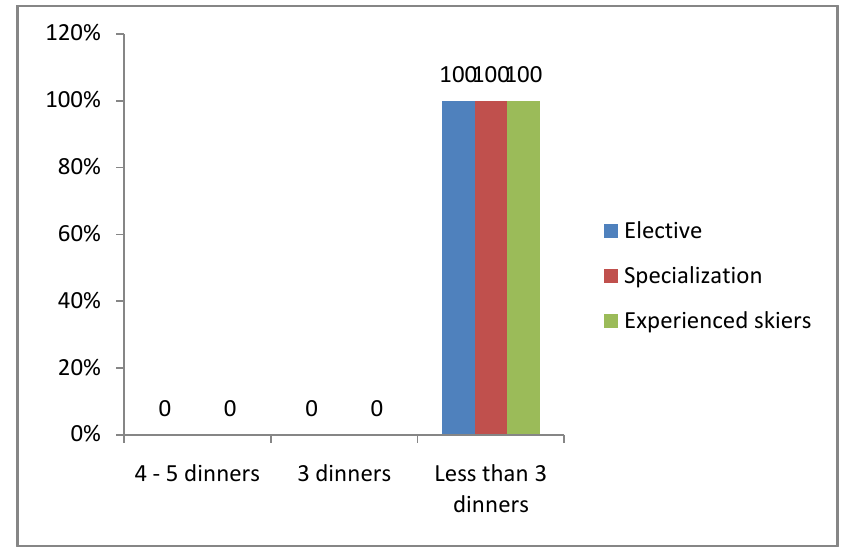
Figure 8. Daily intake of